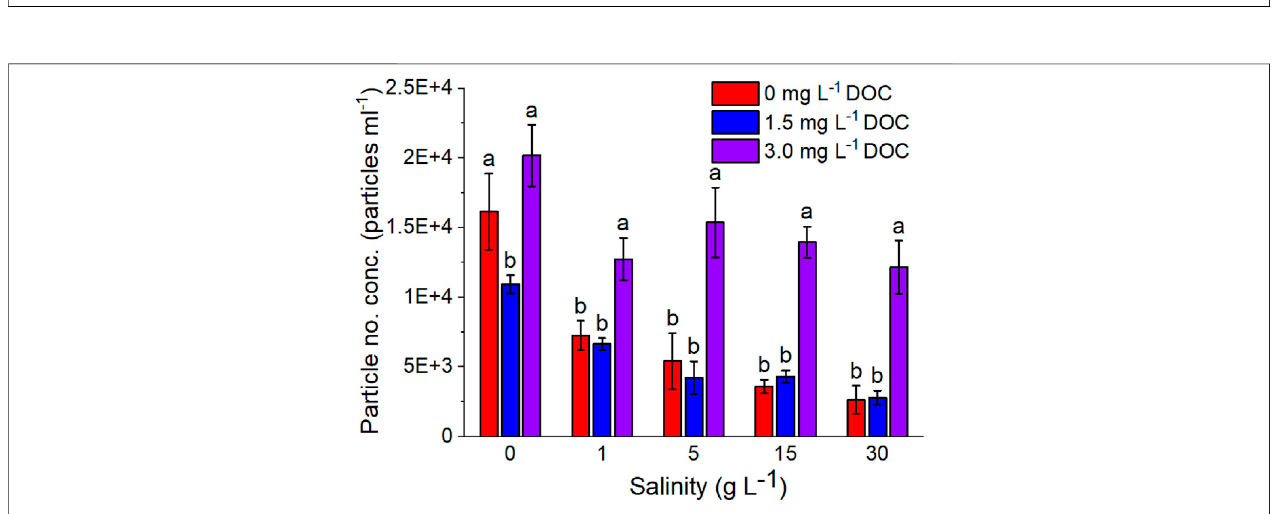
FIGURE 5 | Measured particle number concentrations of Au-Tracer@PS particles in solutions of variable salinity and DOC (SRHA) content ( n (cid:1) 3).